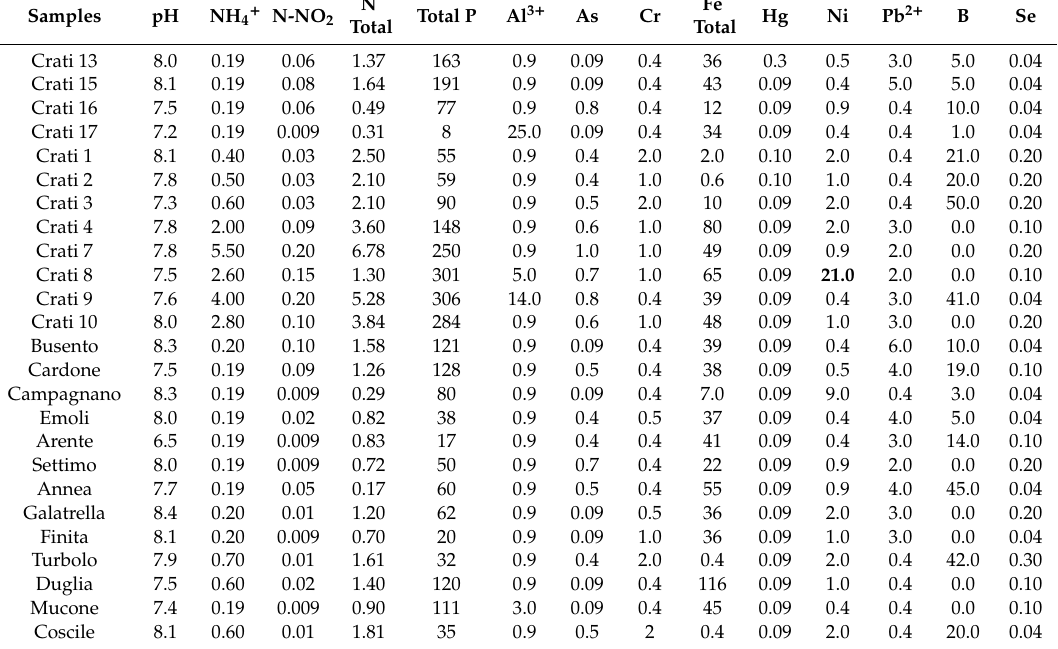
Table 2. Data set including the analytical parameters measured for the water samples. The concentration values are expressed as µ g / mL. Measured values higher than those allowed by the reference standard are shown in